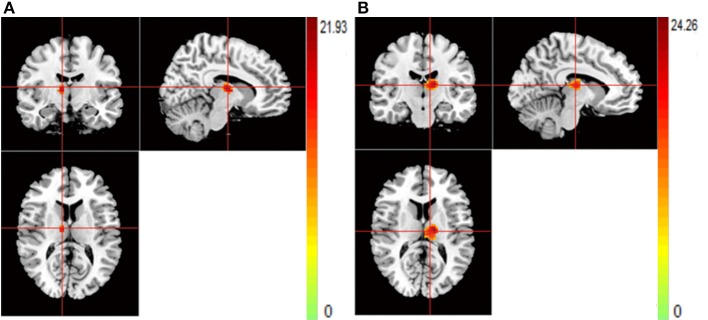
(A,B) The images show the main effect of diagnosis. The hot color indicate that ReHo is higher in HC than SCZ for all SNPs. (A) R-THA (B) L-THA.